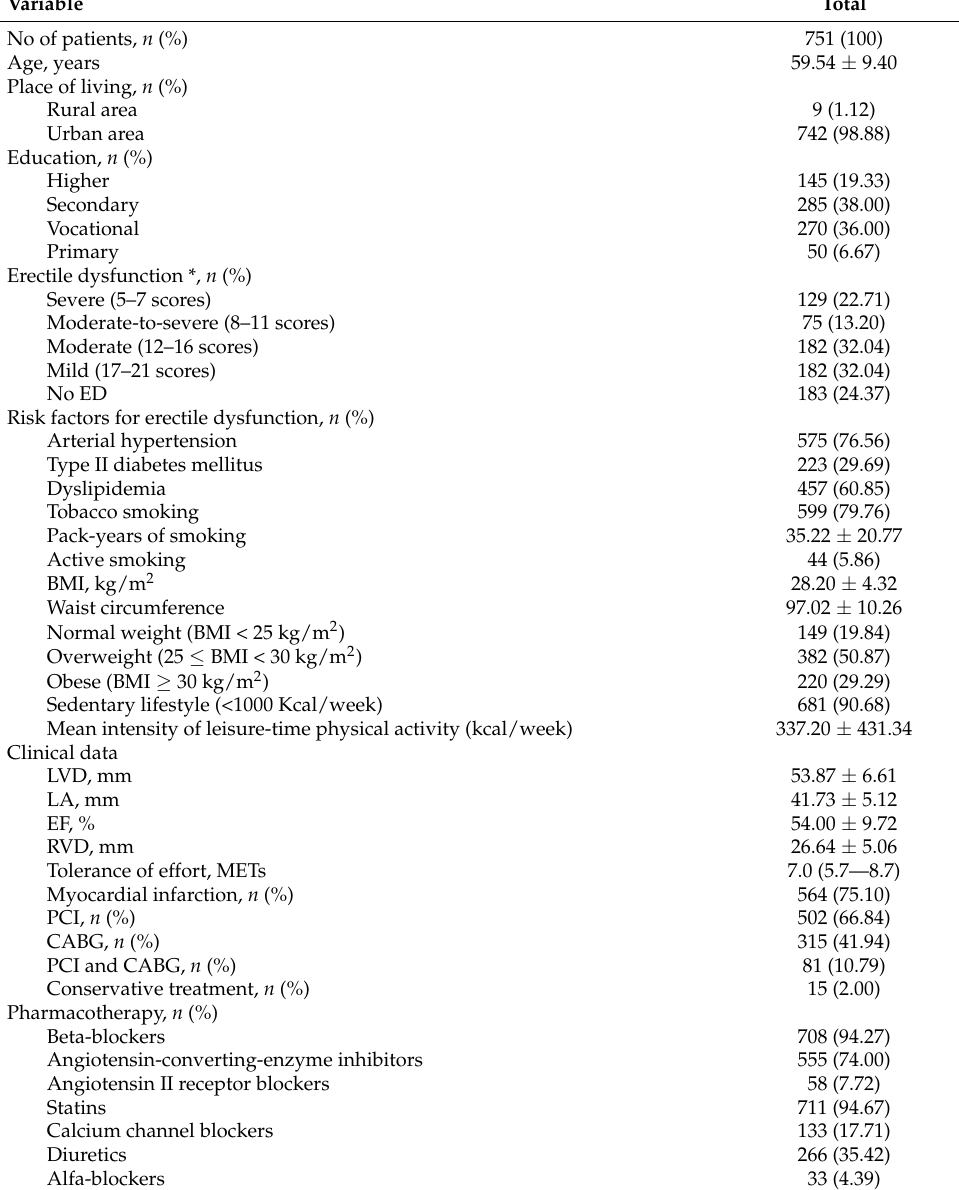
Table 1. Study group